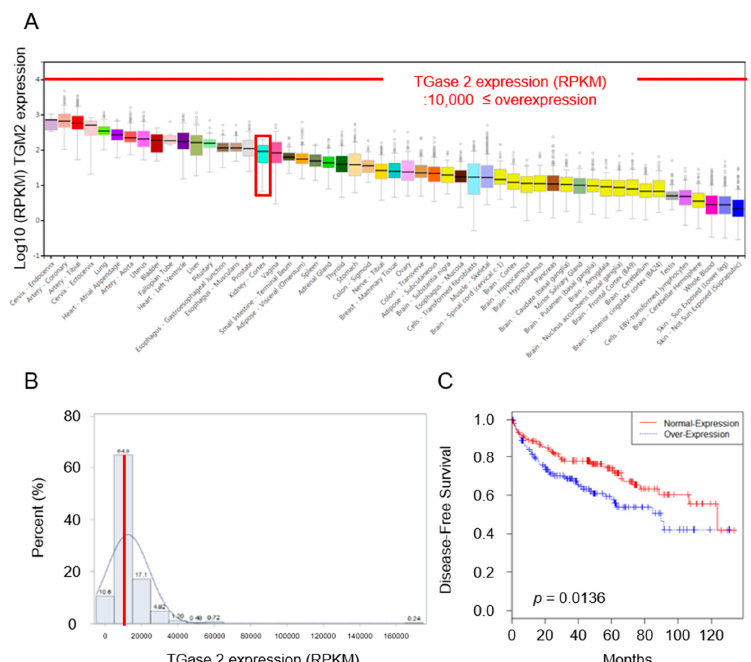
Figure 1. Targeting TGase 2 as a therapeutic approach to renal cell carcinoma (RCC). ( A ) TGase 2 expression in normal tissue (data from The Genotype-Tissue Expression (GTEx) Project). The